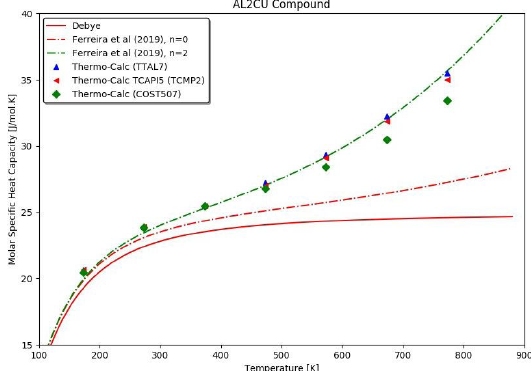
Figure 7. Comparison of the molar heat capacity of the AL2CU phase by carrying out Debye, Thermo-Calc, and Thermo-Calc TCAPI5 simulations and the Ferreira’s model 17 .